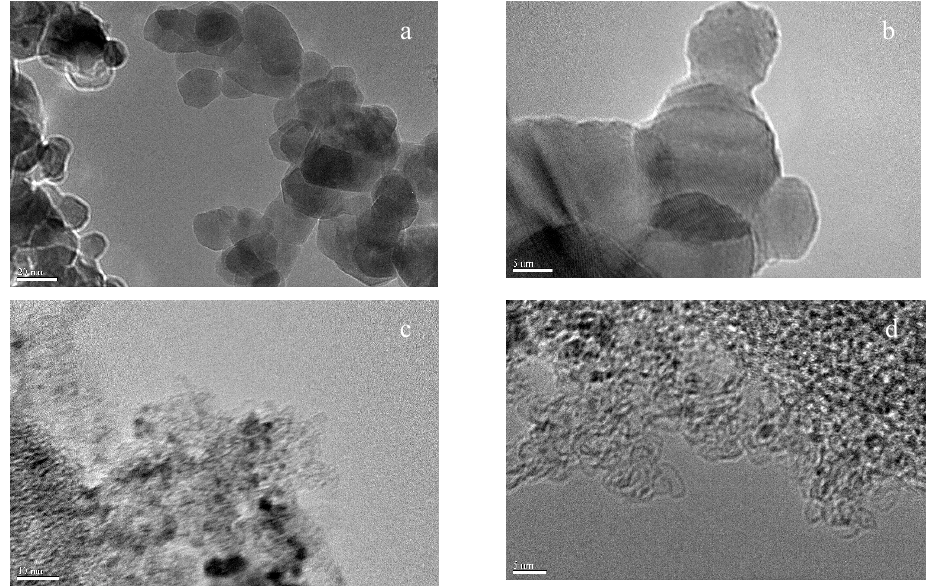
Figure 2. TEM images of unused CAT-I: n-ZnO ( a , b ) and CAT-V: n-Ru/AC catalyst ( c , d ).